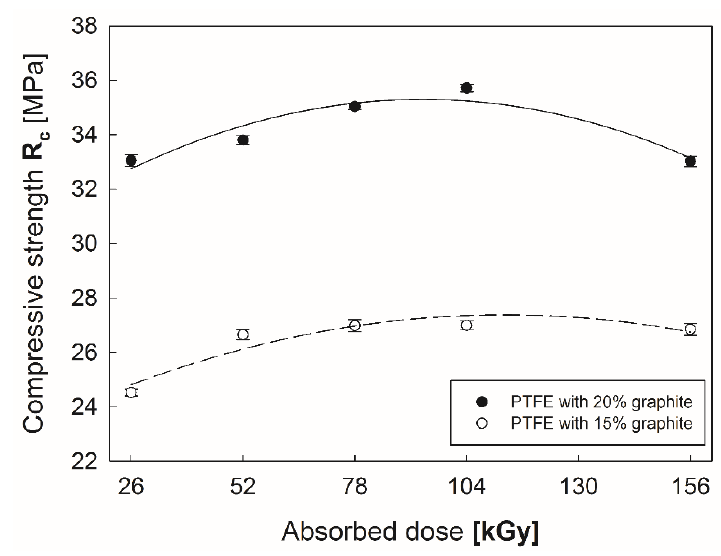
Figure 8. Compressive strength of PTFE with 15% and 20% graphite addition. subjected to an absorbed dose of electron beam irradiation.